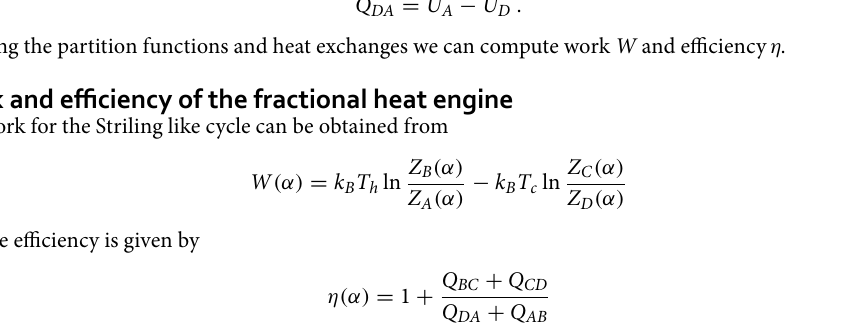
31 9.11 10 1.380649 kg, k B − = × =